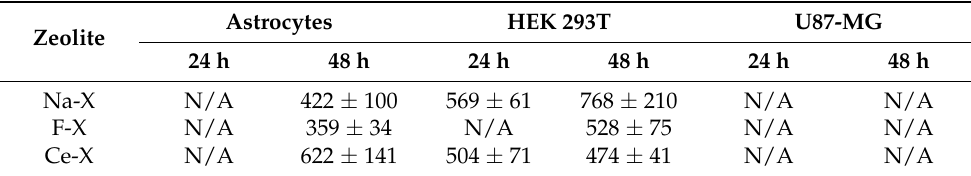
Table 2. Half maximal inhibitory concentration (IC50) values ( µ g/mL) for three cell lines (Astrocytes, HEK 293T, U87-MG) in the presence of Na-X, F-X, and Ce-X zeolites. Zeolite